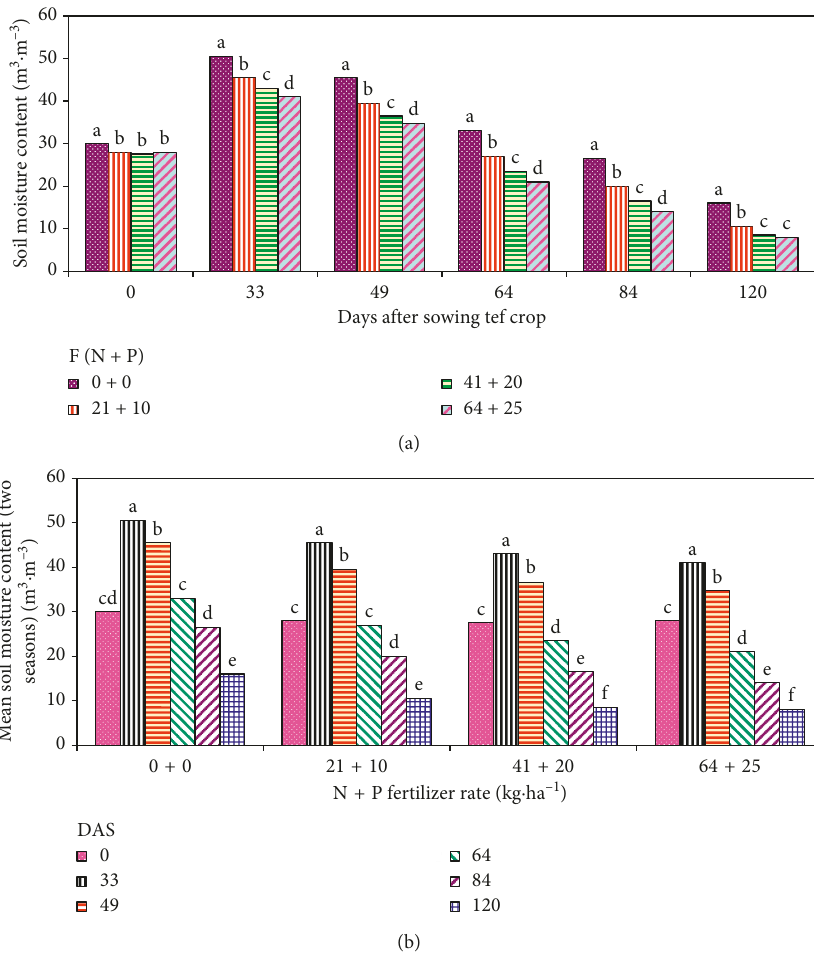
Figure 5: Average soil moisture content of 2012 and 2013 as affected by (a) fertilizer rates in a given sampling date and (b) growth stages (sampling dates) for the same fertilizer rate. Note: F (N+P) denotes fertilizer N plus P (kg · ha − 1 ) as 0 N+0 P (F1), 21 N +10 P (F2), 41 N +20 P (F3), and 64 N +25 P (F4); DAS, days after sowing, refers to the soil sampling date to determine